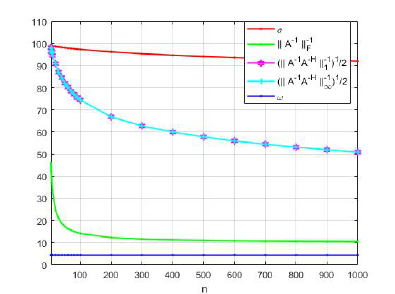
Figure 4: a 1 , a 2 , a 3 , a 4 , a 5 = 20/9, 1/9, 2/9, 1/3, 5/9 [i=5].